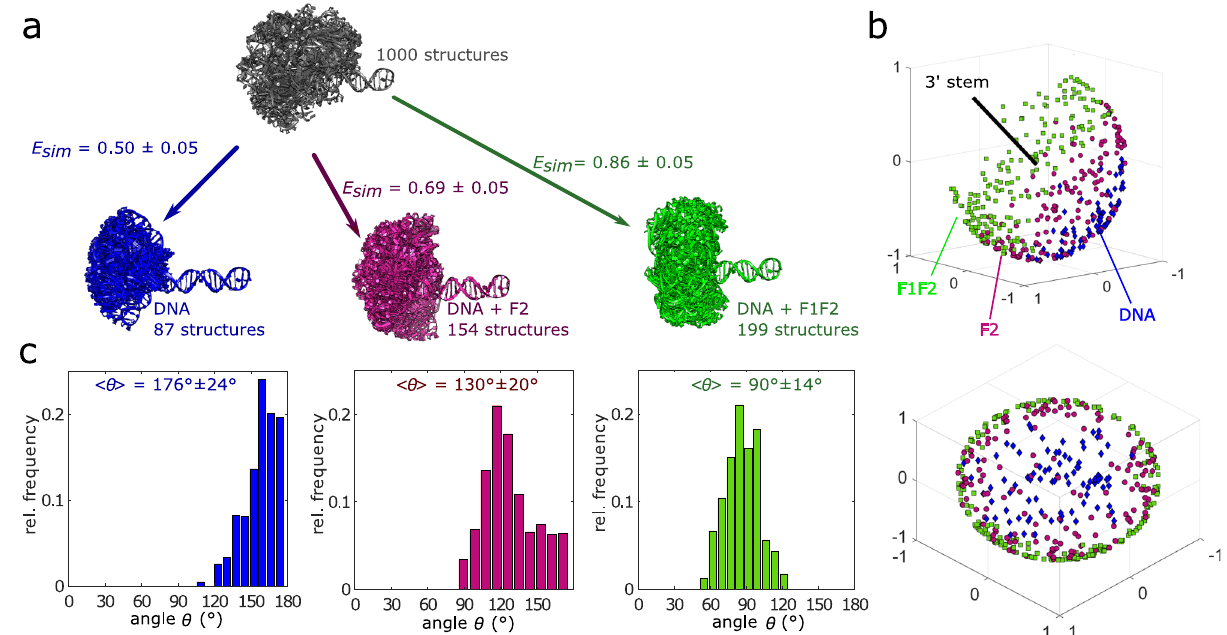
Fig. 4 | From structural ensembles to kinking angle histograms. a Anensemble of 1000 possible structures for the DNA was calculated (only 100 structures are showninthe fi guresforclarity,grey).Fromthisensemble,structuresinagreement with the experimental FRET ef fi ciencies were selected, i.e. 87 for free DNA (blue), 154 for DNA+F2 (magenta) and 199 for DNA+F1F2 (green). b Combined repre- sentation of the selected structures shown in a . All structures are aligned with respect to the 3 ′ stem. The axis of the 3 ′ stem is represented by a black line. The